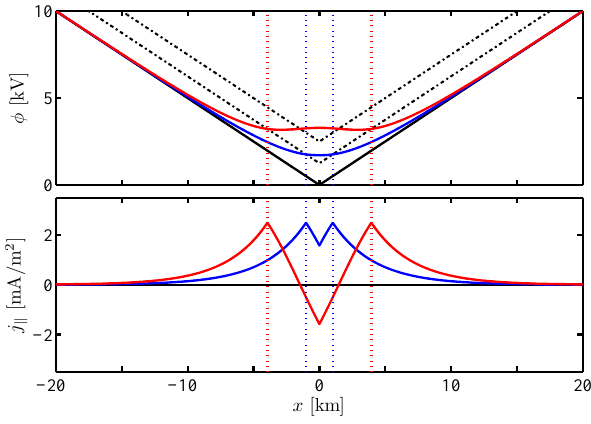
Fig. 8. Magnetospheric and ionospheric electric potential ˆ φ (black) and φ (blue and red) and field-aligned current j k (blue and red) for a converging electric field ( (cid:15) = 500mV/m), a conductivity of 6 P = 20 S, and a nonmonotonic current-voltage relation j k = K + 1φ for 1φ < 1φ ∗ and j k = 2 K + 1φ ∗ − K + 1φ for higher parallel potential drop. Dotted black lines indicate 1φ = 1φ ∗ (where the current is maximum) and 2 1φ ∗ (where the current is zero), with K + = 2mA/kVm 2 and 1φ ∗ = 1 . 25kV. The two curves correspond to two different solutions for the same boundary conditions.